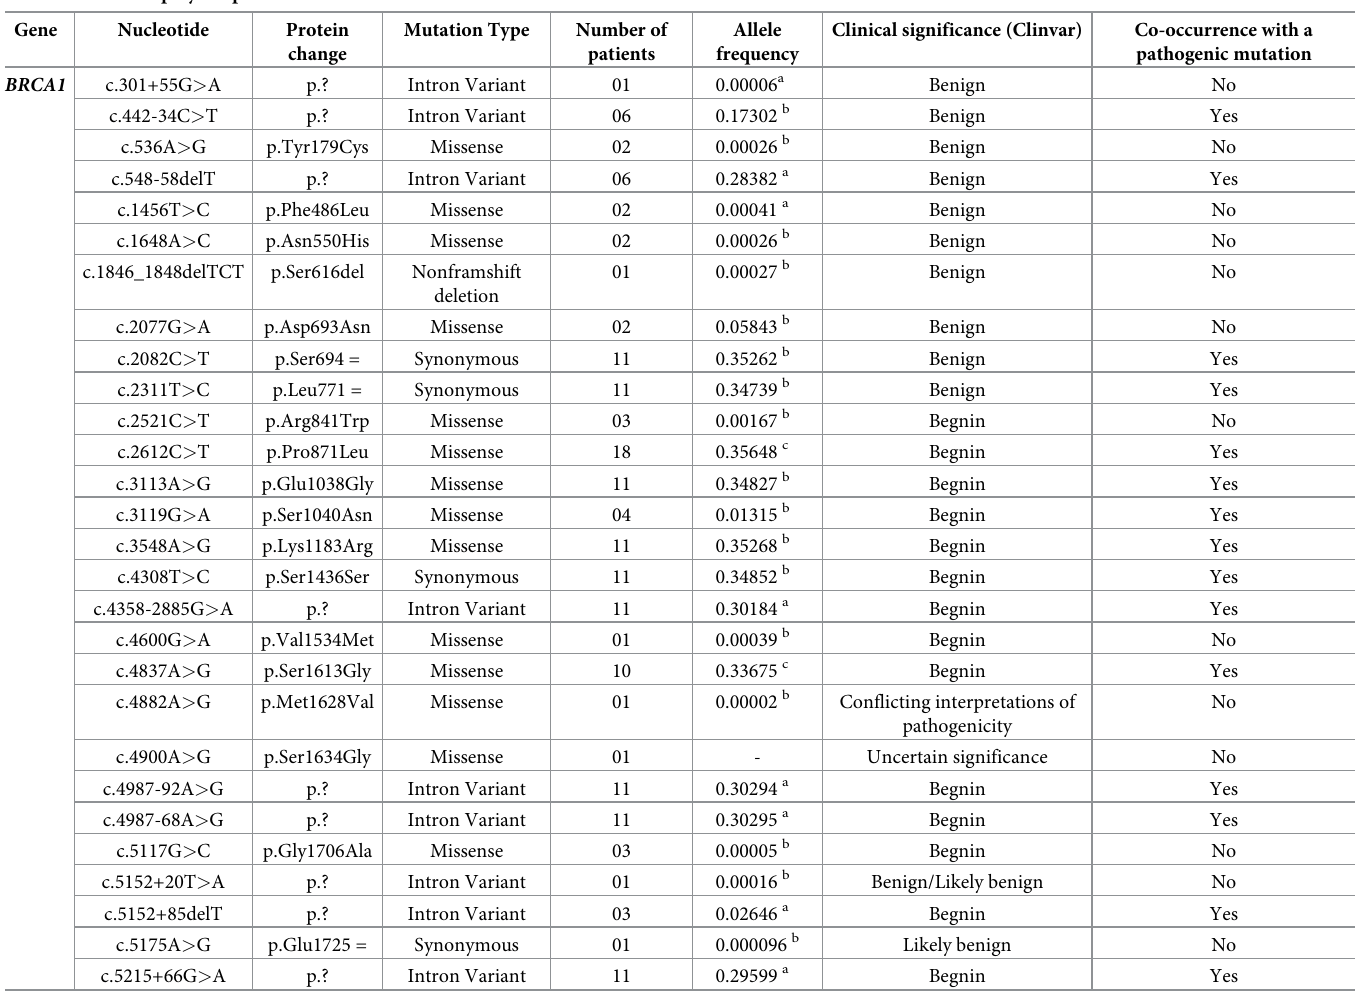
Table 3. BRCA1 /2 polymorphisms and unclassified